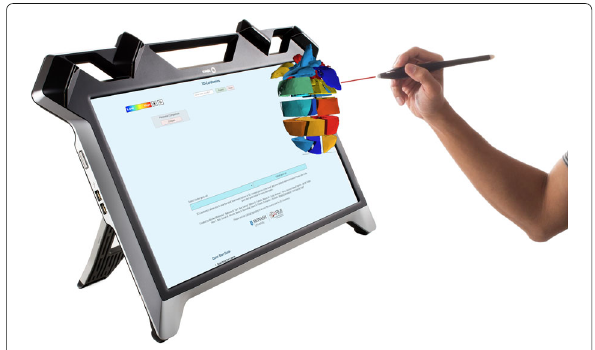
Fig. 4 Exemplary representation of 3D-Cardiomics zSpace